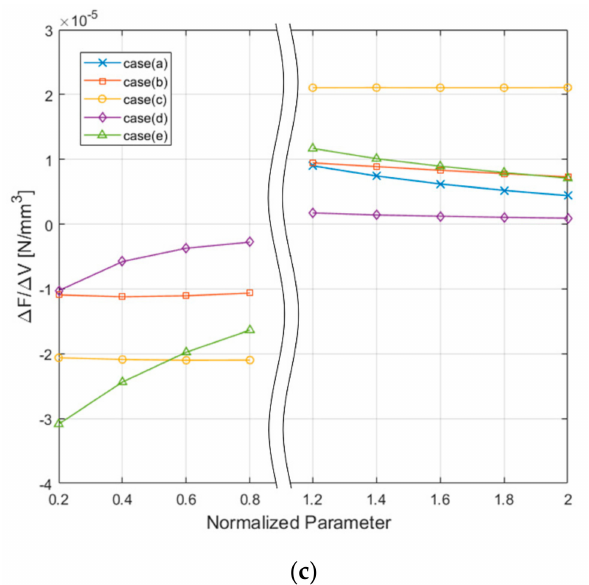
Figure 6. Results of analysis of the HVCM, ( a ) Force, ( b ) Average magnetic flux density, ( c ) force increase per volume